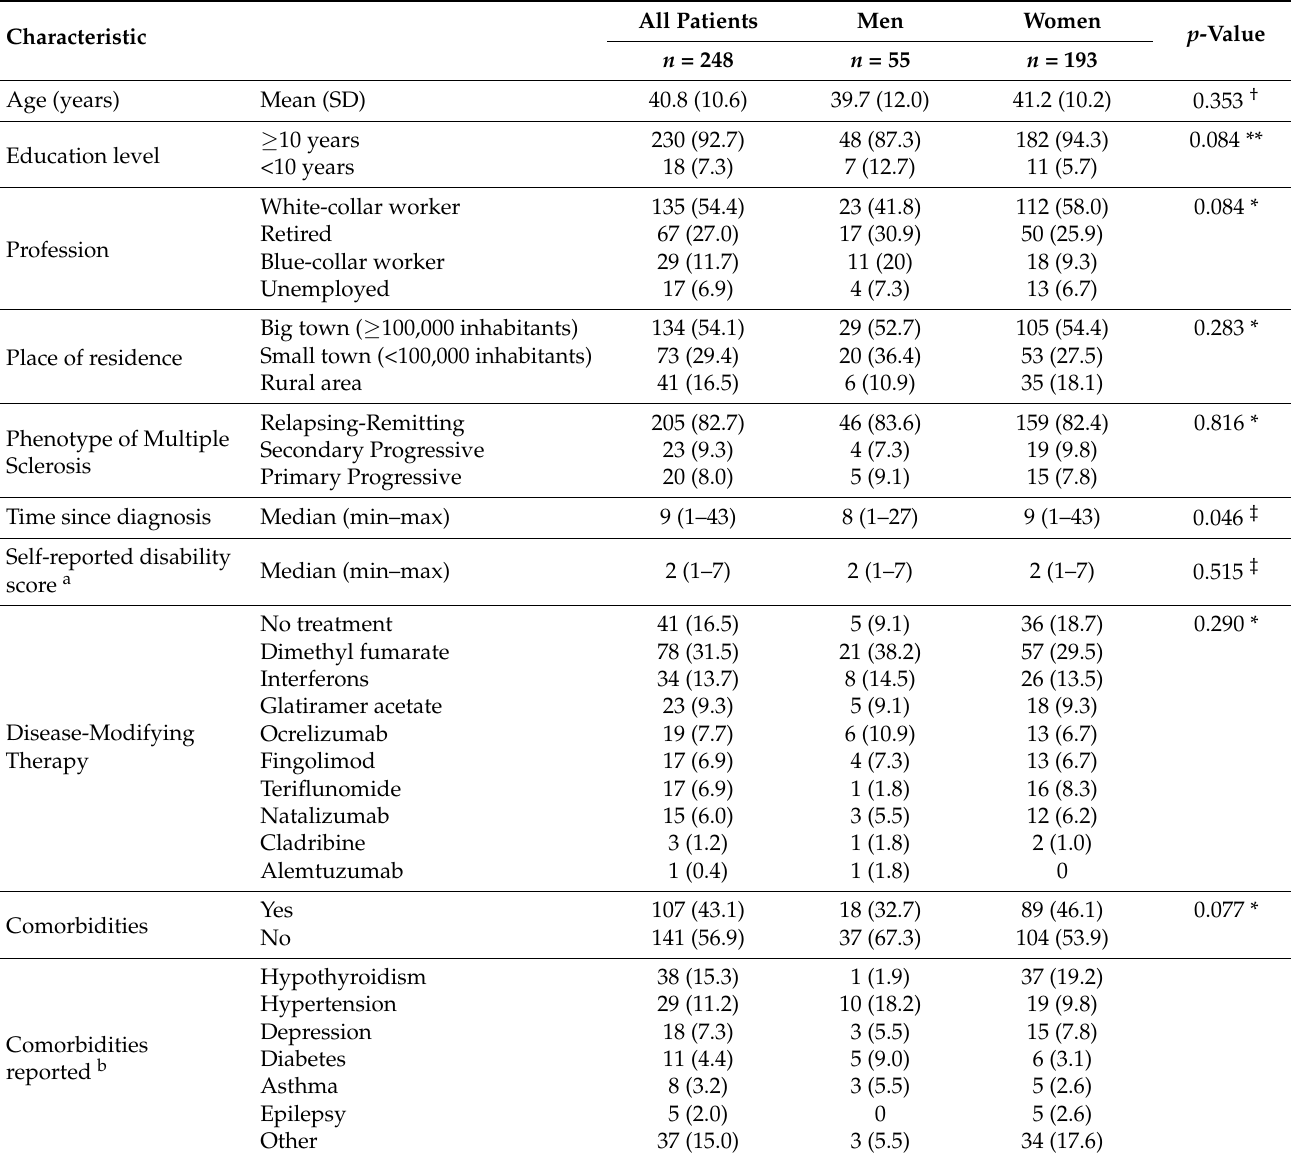
Table 1. Demographic and clinical characteristics of all respondents with multiple sclerosis, and differences between men and